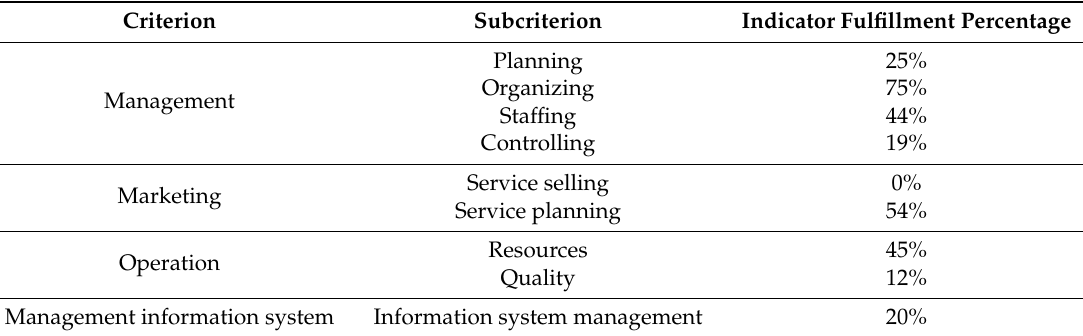
Table 5. Subcriteria readiness